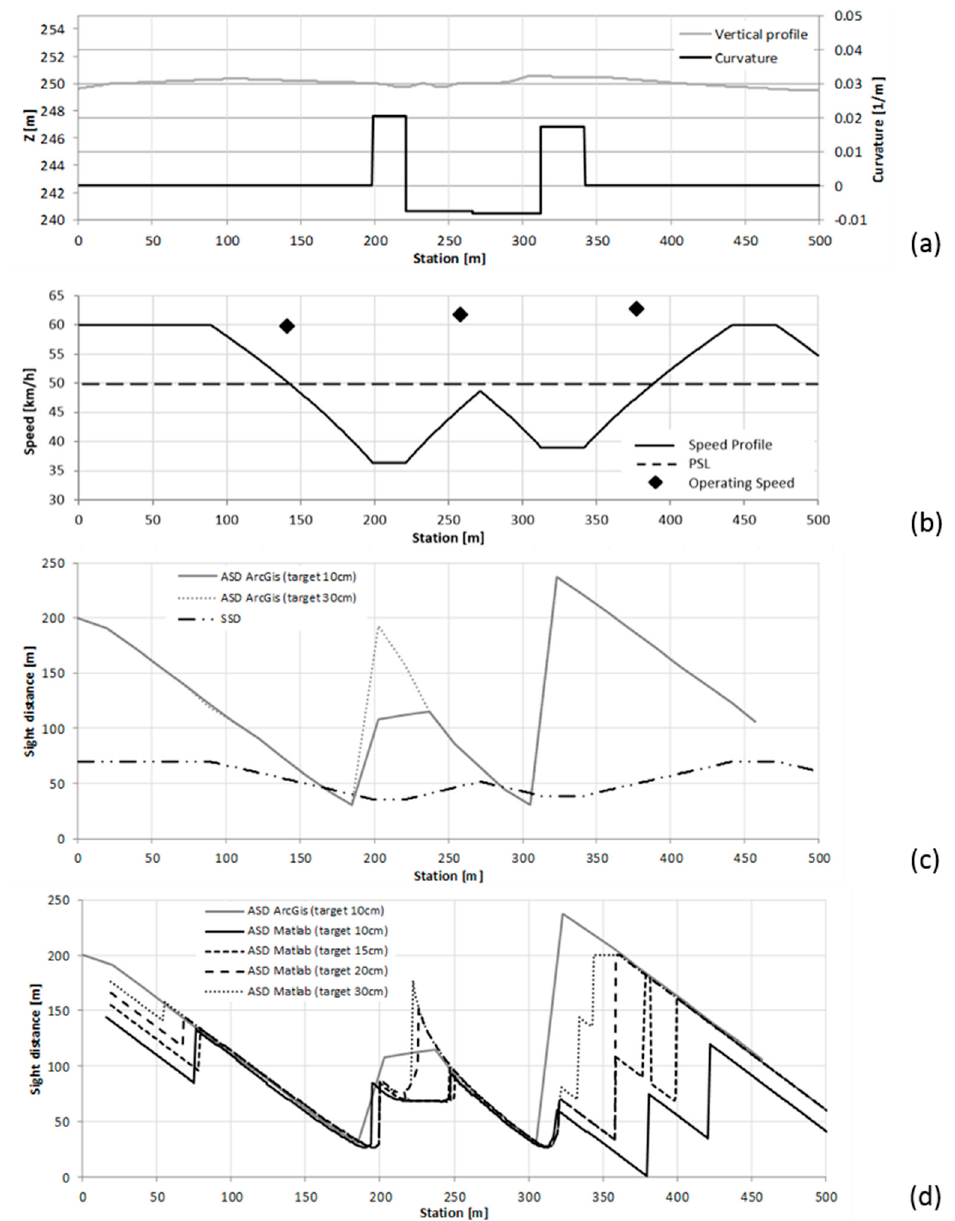
Figure 10. ( a ) Vertical profile and trajectory curvature; ( b ) design speed profile and operating speed values; ( c ) comparison between stopping sight distance (SSD) and ASD, estimated at 10 cm and 30 cm in accordance with the ArcGIS® code; ( d ) comparison between ASD estimated with ArcGIS® and Matlab® at 10 cm, and the variation in Matlab® solutions at 15, 20, and 30 cm.